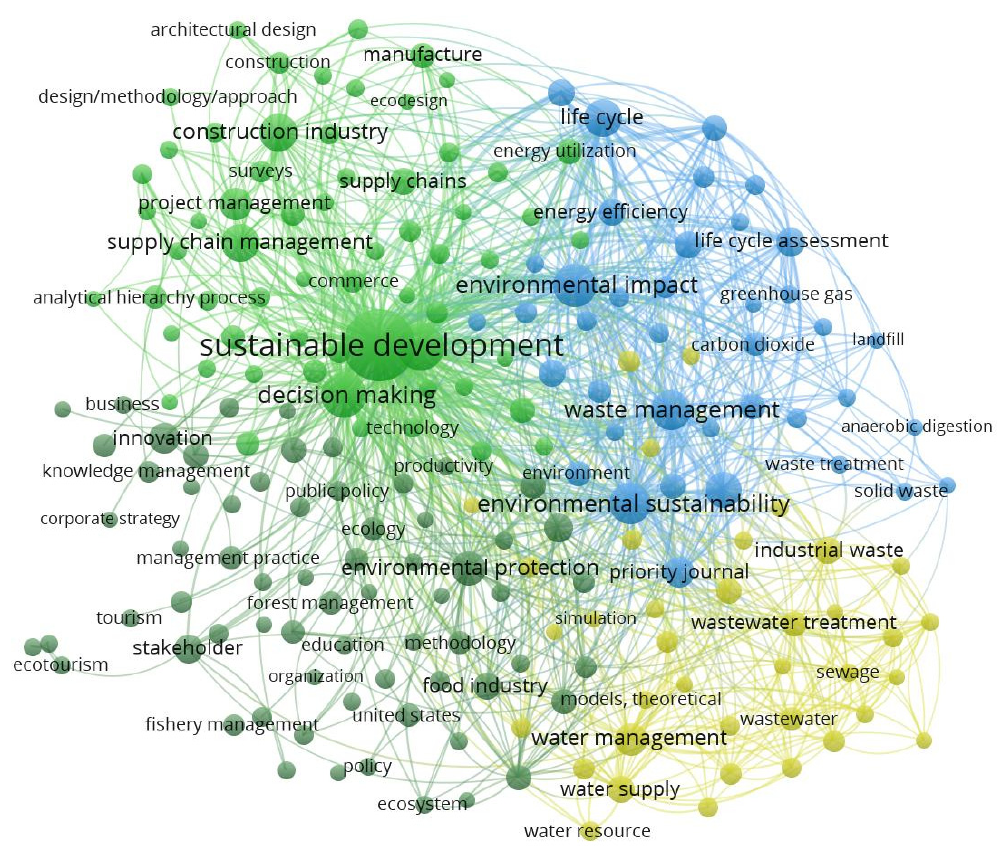
Figure 6. Keywords network map based on co-occurrence (1998–2019).